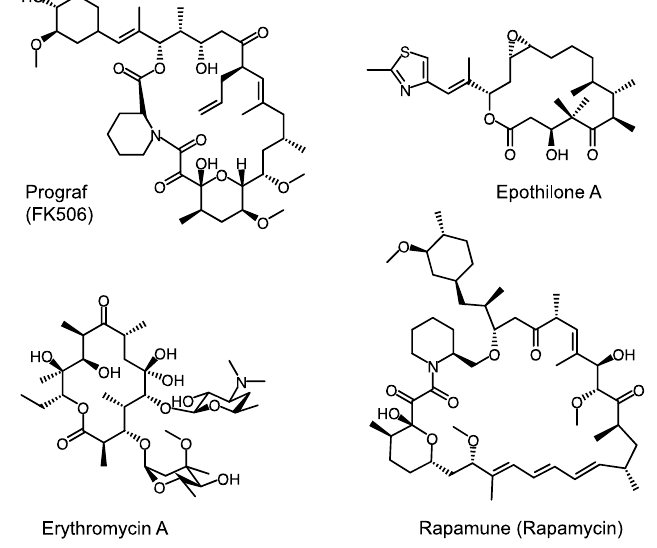
Figure 1. Bioactive polyketides with diverse structure produced by mPKSs [6,7].